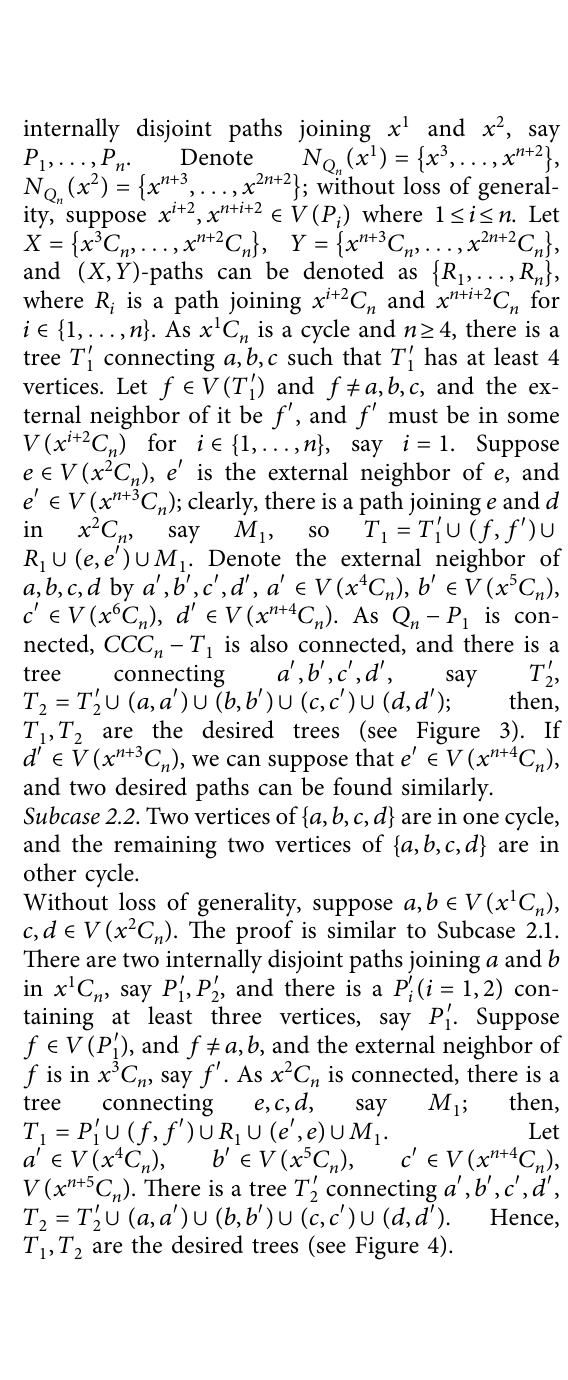
Figure 3: Te illustration of subcase 2.1 of Teorem